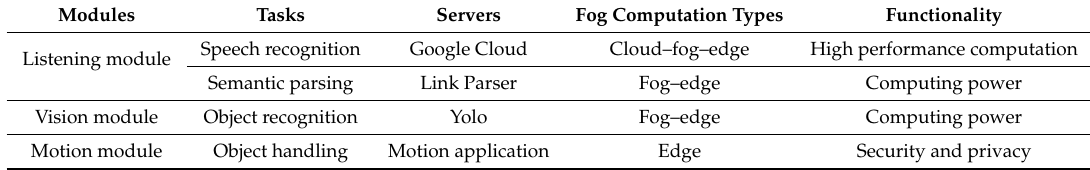
Table 5. The functions of the robot and service